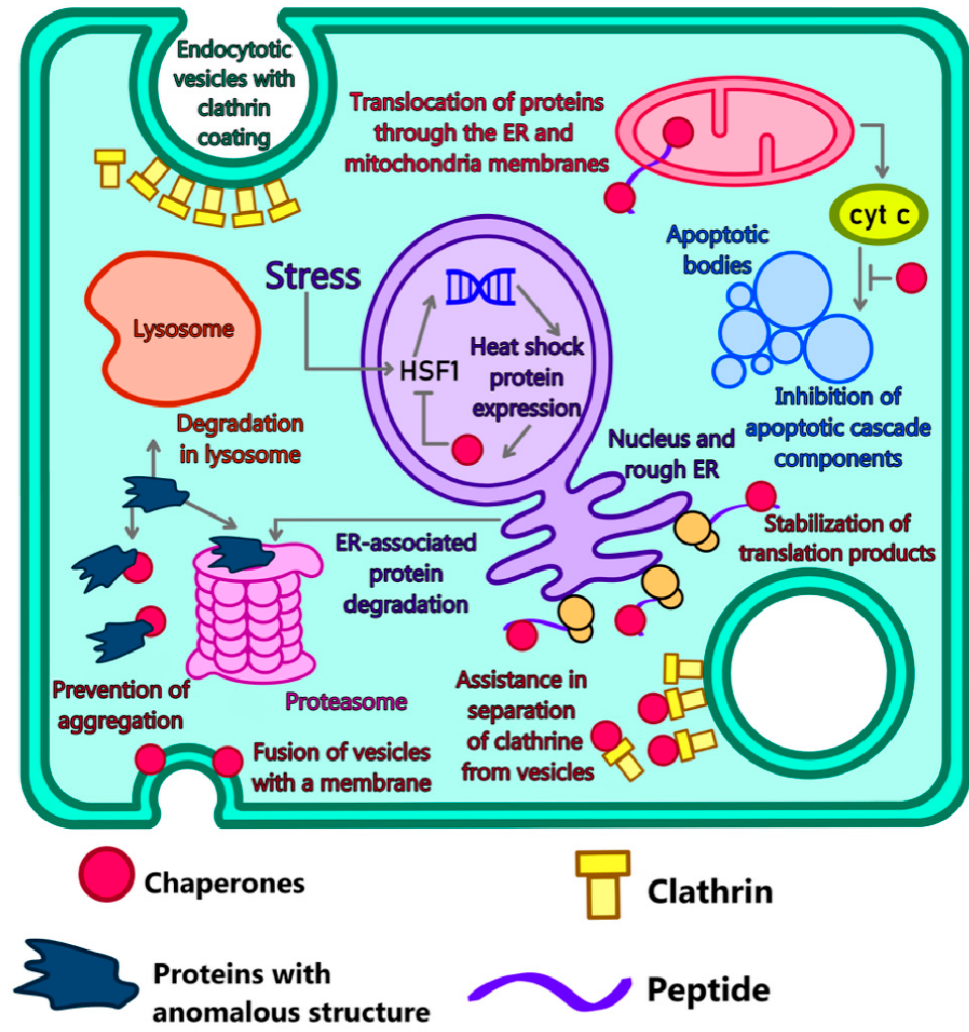
Figure 1. Diagram of intracellular chaperone system to fight abnormal proteins. Acting as a kind of assistant for the formation of a normal tertiary protein structure or, conversely, its degradation, chaperones are a universal system for preventing proteinopathies, which are the main cause of neurodegenerative diseases.